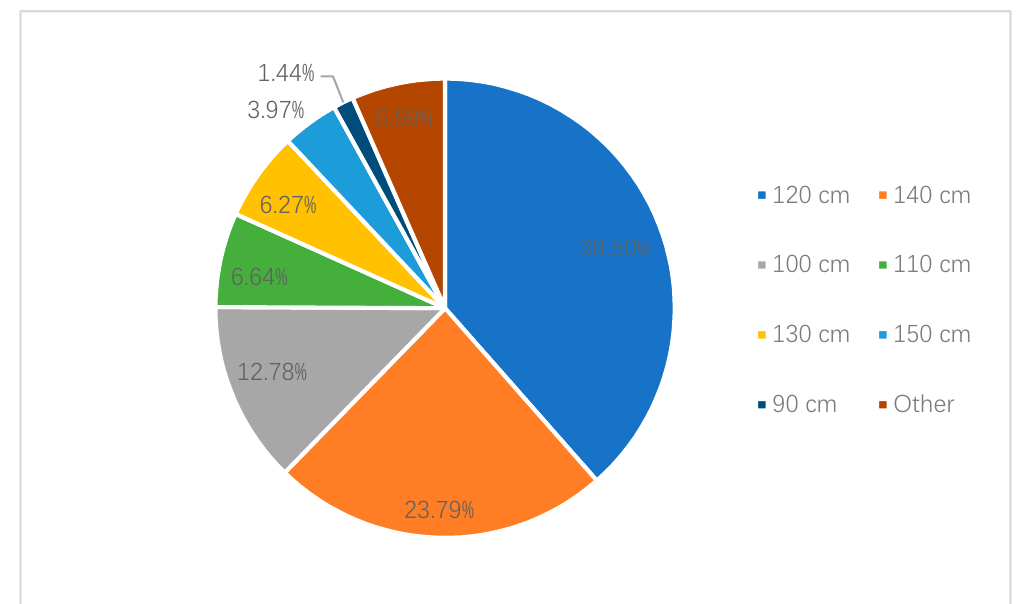
Figure 4. Recognized height criteria of national child restraint legislation by parents in Shenzhen.